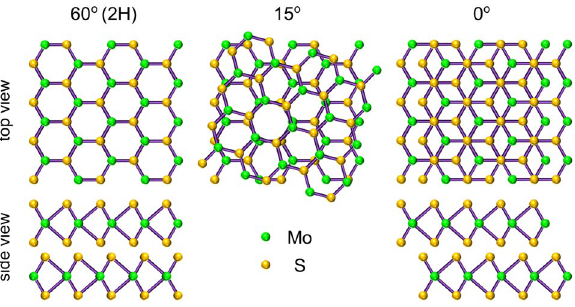
Figure 1. Atomic structure and stacking order of bilayers MoS 2 for different twist angles: 60 ◦ , 15 ◦ and 0 ◦ . Note that the side view demonstrates the energetically favourable structures for angles of 60 ◦ and 0 ◦